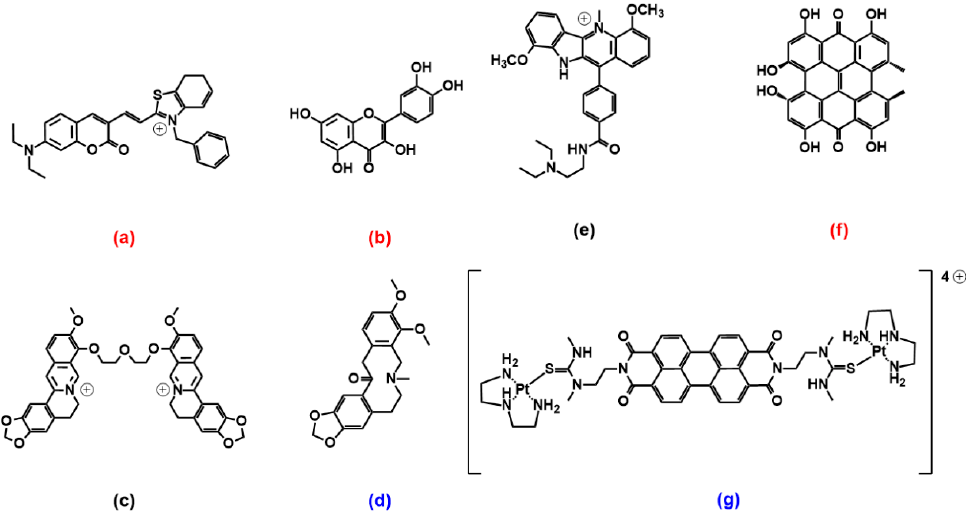
Figure 6. Molecular structures of the selective G4 binders of the pericyclic compounds family reviewed here: ( a ) [67], ( b ) [68], ( c ) [69], ( d ) [70], ( e ) [71], ( f ) [72] and ( g ) [73]. Red letters evidence parallel G4s high selectivity, blue letters correspond to molecules selective for antiparallel topology, and the systems with other/mixed behaviour have black lettering.